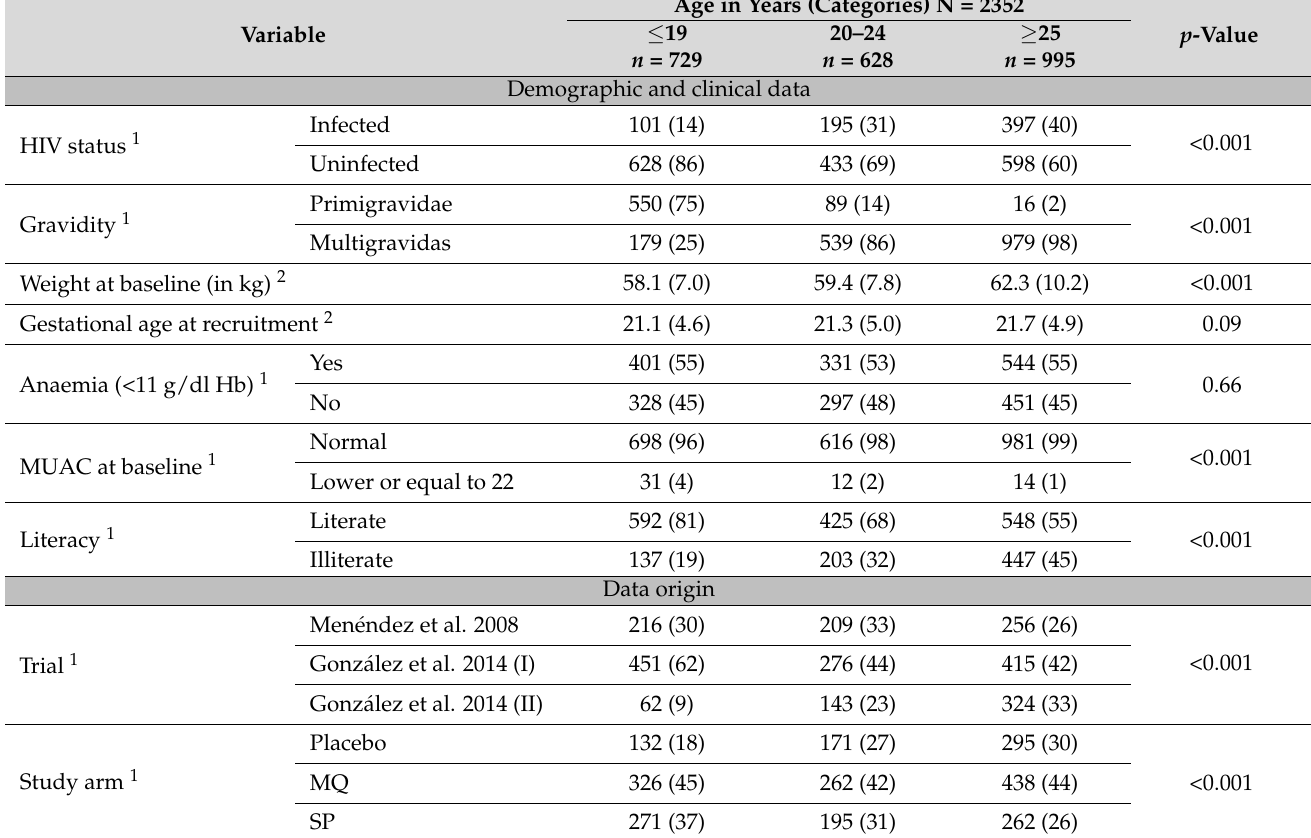
Table 1. Characteristics of study population, by age